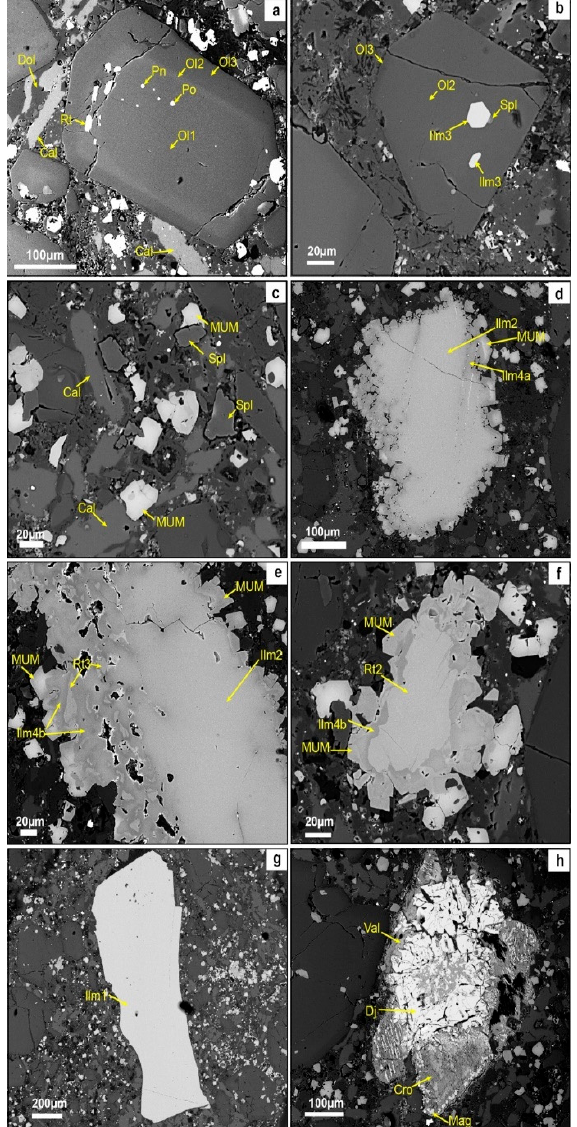
Figure 2. ( a ) A zoned euhedral olivine phenocryst. Olivine 1 (Ol1) is anhedral and contains inclusions of pentlandite (Pn) and pyrrhotite (Po); the ensemble has a first rim of olivine 2 (Ol2) containing rutile (Rt1) and an outermost rim of olivine 3 (Ol3); ( b ) ilmenite (Ilm3) and spinel (Spl) found as inclusions in olivine 2 (Ol2); ( c ) spinel s.s. (Spl), ulvöspinel–ulvöspinel–magnetite (MUM), calcite (Cal), and dolomite (Dol) coexist in the groundmass; ( d ) ilmenite (Ilm2) replaced first by ilmenite 4a (Ilm4a) and finally by MUM; ( e ) ilmenite (Ilm2) replaced by rutile (Rt3), and lastly replaced by geiliete (Ilm 4b) and MUM; ( f ) microcrystic rutile (Rt2) replaced by ilmenite (Ilm 4b) and MUM; ( g ) homogeneous ilmenite (Ilm1) not replaced by other minerals; ( h ) djerfisherite (Dj) replaced by valleriite (Val), magnetite (Mag), and cronstedtite